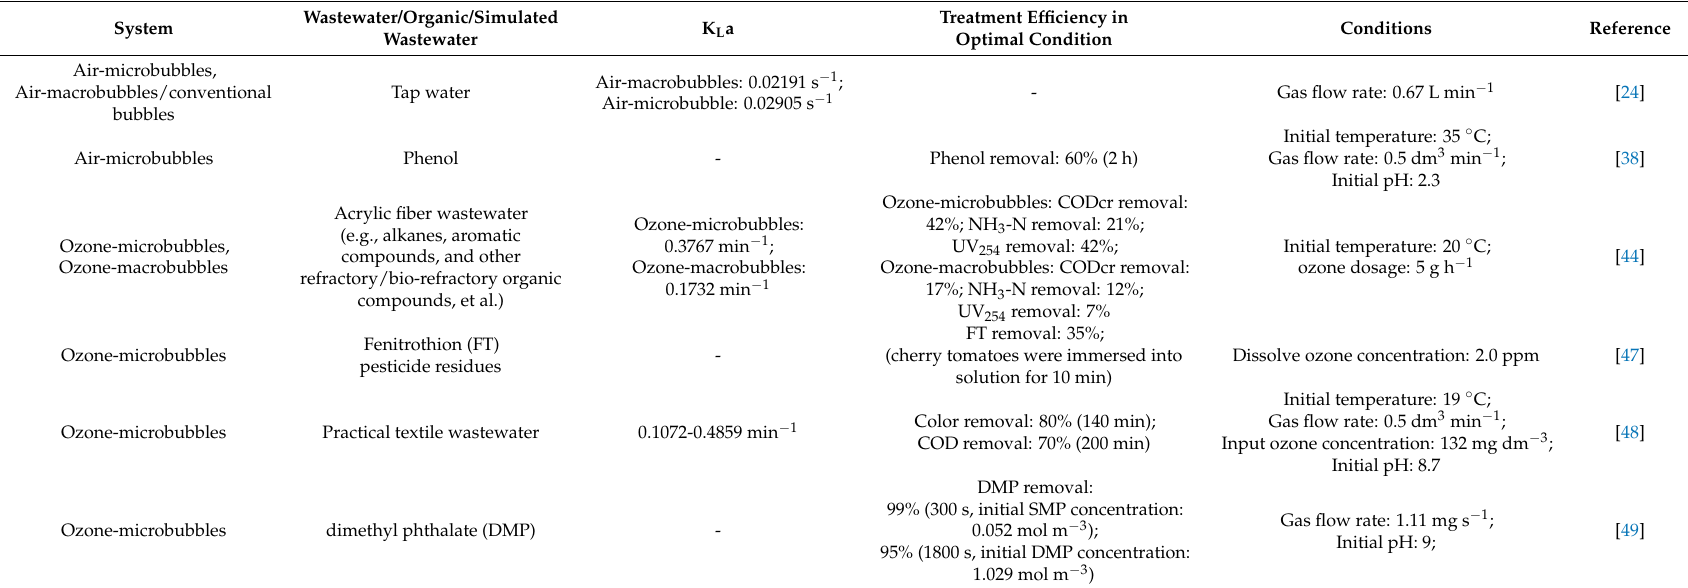
Table 1. Overview on wastewater treatment through microbubbles